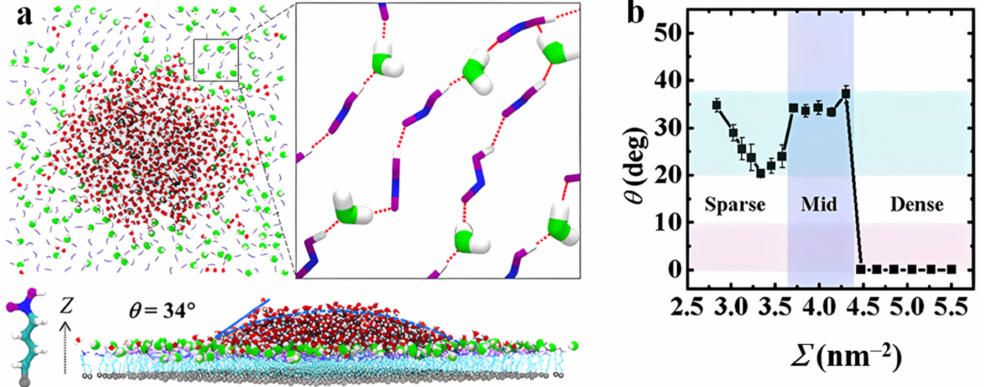
Figure 4. ( a ) Side-view snapshots of water droplets and sparse water molecules outside the droplet on COOH-SAM with a packing density of Σ = 4.00 nm − 2 , together with top and side view snapshots of water on COOH SAM (model atoms: gray; COOH groups: blue, purple, and white; water: red and white; embedded water: green and white; alkyl chains: blue lines in side view, but omitted for clear views in the top view; H-bonds: red, dashed lines). ( b ) Dependence of contact angle values θ of water droplets on packing density Σ of COOH-SAMs. We marked the mid-range in light blue. (Reprinted from Ref. [131], Copyright 2015 American Physical